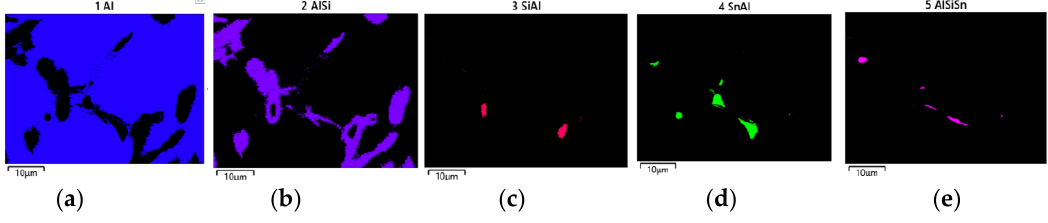
Figure 18. SEM-EDS image of AlSi10Sn1.7 alloy (1—Al; 2—AlSi; 3—Si; 4—SnAl; 5—AlSiSn). Table 8. Phases in AlSI10Sn1.7 alloy in micro area from Figure 18.